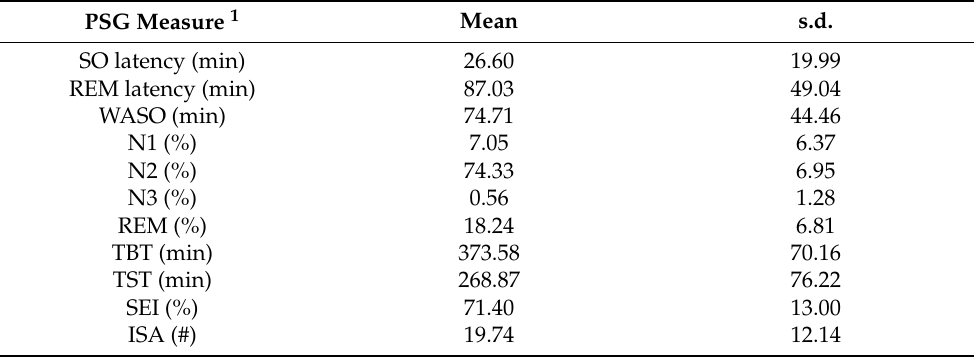
Table 1. Sleep macrostructure. Descriptive statistics (means and standard deviations) of the macrostructural variables of sleep from the PSG recordings in the AD